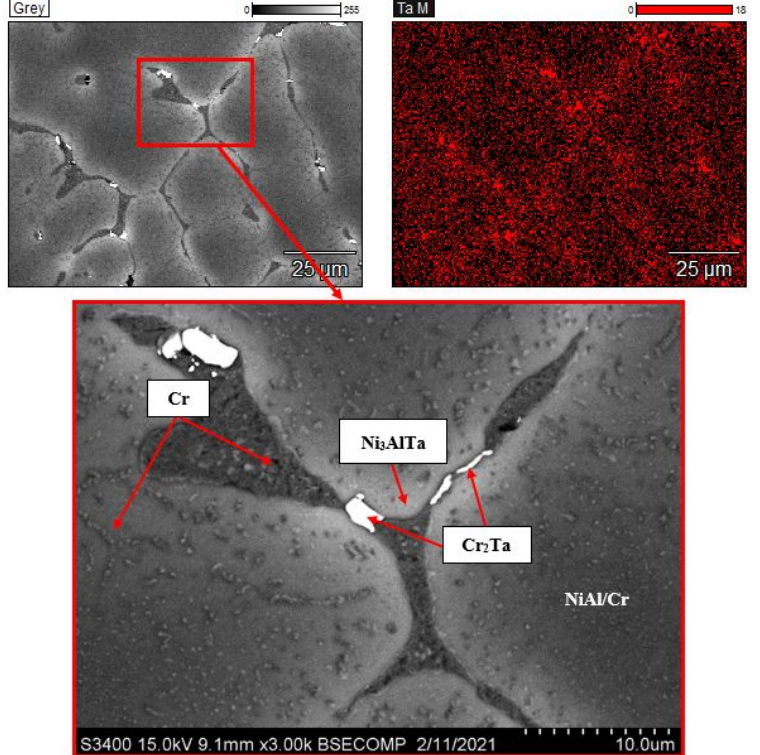
Figure 7. The microstructure of the alloy doped with 2.5% of tantalum and the map of dopant dis- tribution.